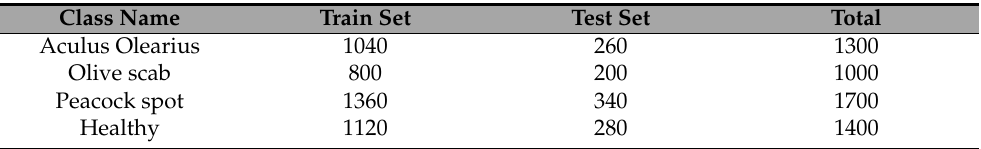
Figure 4. Conceptual overview of the proposed work. Table 2. Dataset